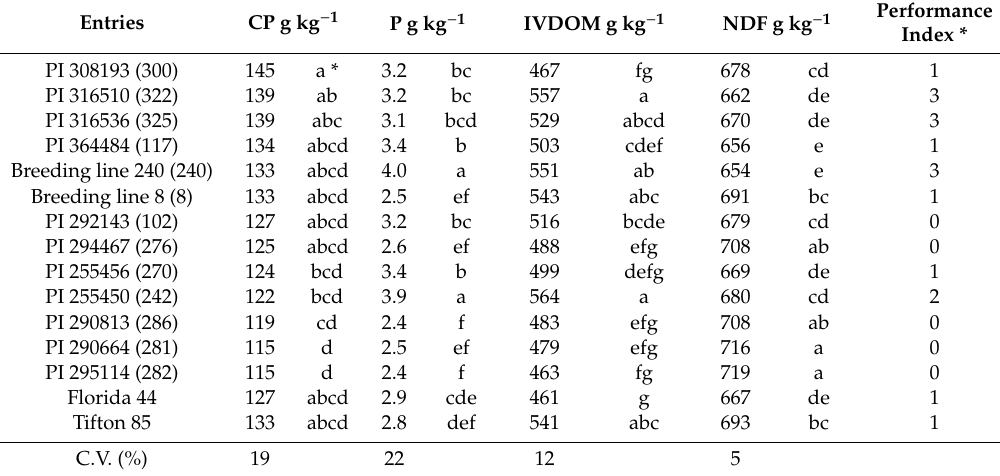
Table 4. Average nutritive value for selected bermudagrass plant introductions (PI), breeding lines, and cultivars across eleven harvests evaluated in Citra, FL.